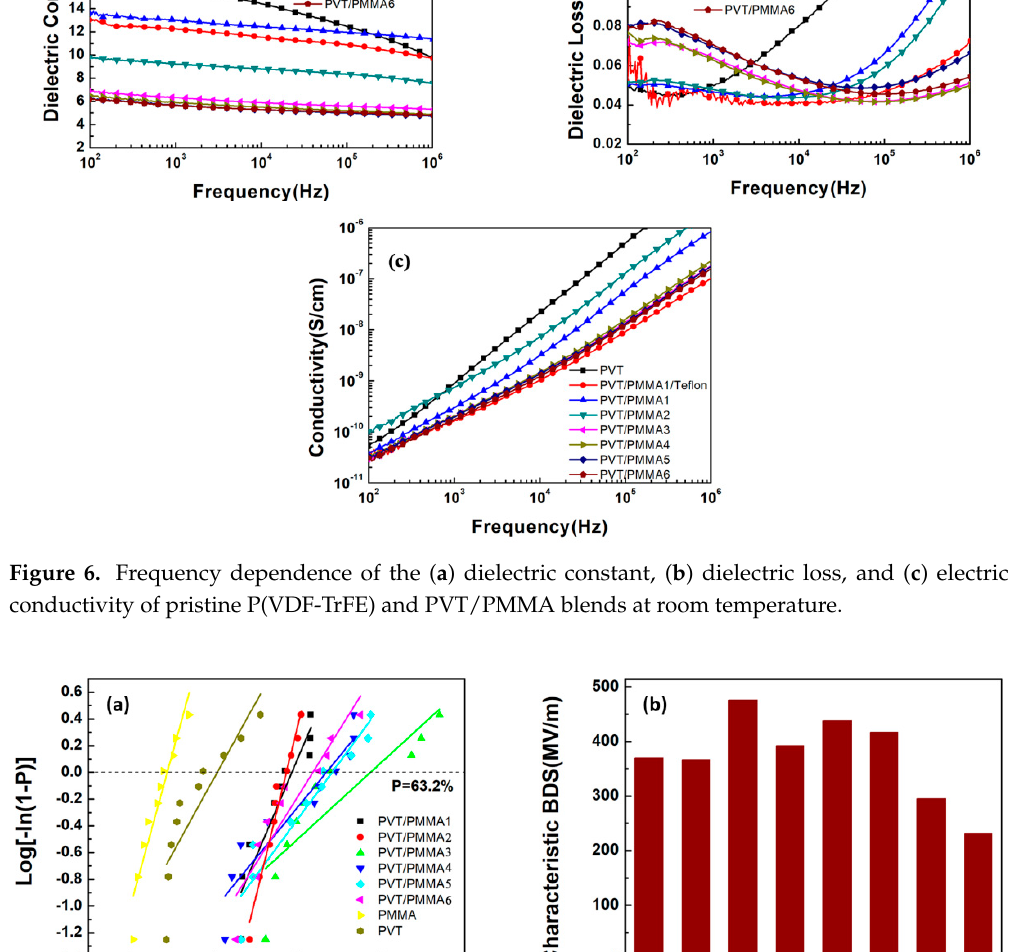
Figure 6. Frequency dependence of the ( a ) dielectric constant, ( b ) dielectric loss, and ( c ) electric conductivity of pristine P(VDF-TrFE) and PVT/PMMA blends at room temperature.